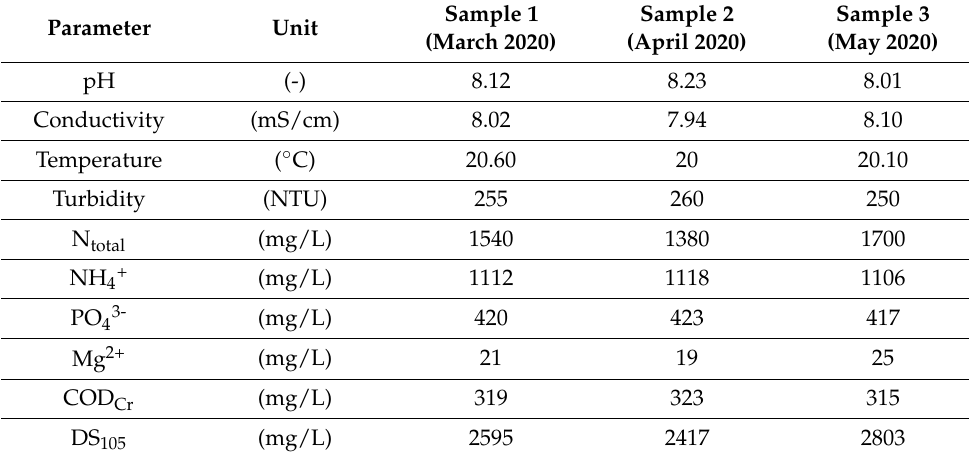
Table 1. Physicochemical parameters of input